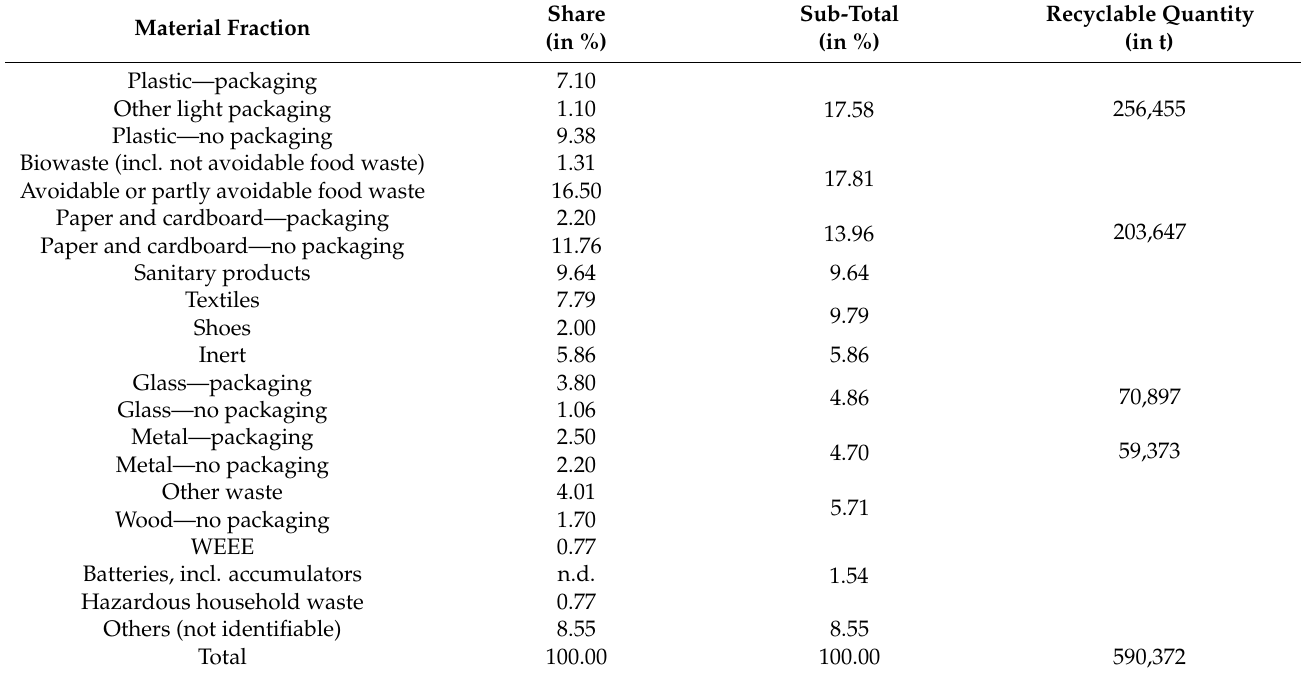
Table 2. Composition of mixed municipal waste and the contained share of recyclables in Austria for the year 2018 [21]. Material Fraction